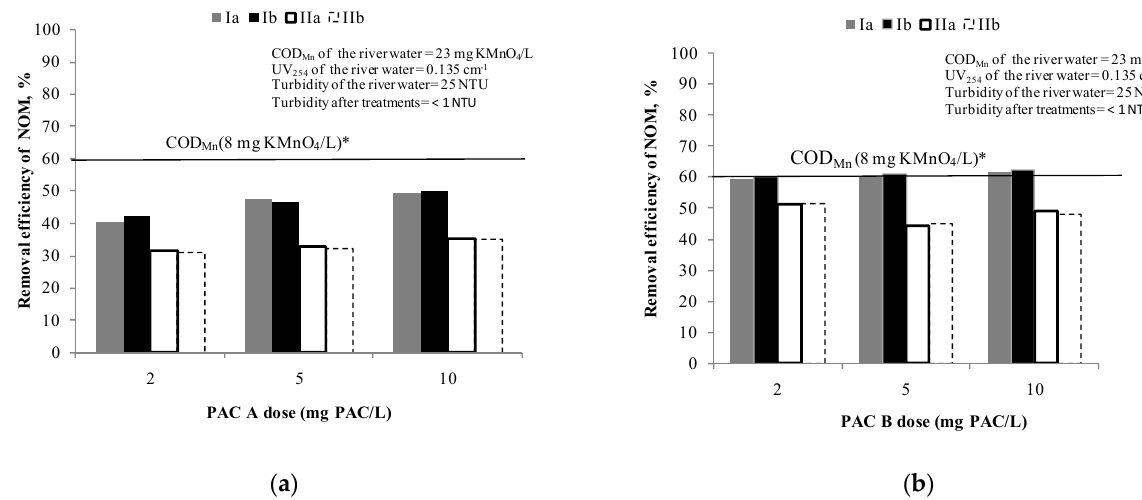
Figure 2. Removal efficiency of NOM by: ( a ) PAC A /S (doses: 2, 5 and 10 mg PAC/L) and ( b ) PAC B /S(doses: 2, 5 and 10 mg PAC/L). Note: Ia—removal efficiency (COD Mn ) in experiment; Ib—removal efficiency (COD Mn ) in experiment duplicate; IIa—removal efficiency (UV absorbance at 254 nm) in experiment; IIb—removal efficiency (UV absorbance at 254 nm) in experiment duplicate; * The line represents the removal efficiency when target value of COD Mn of 8 mg KMnO 4 /L was achieved.